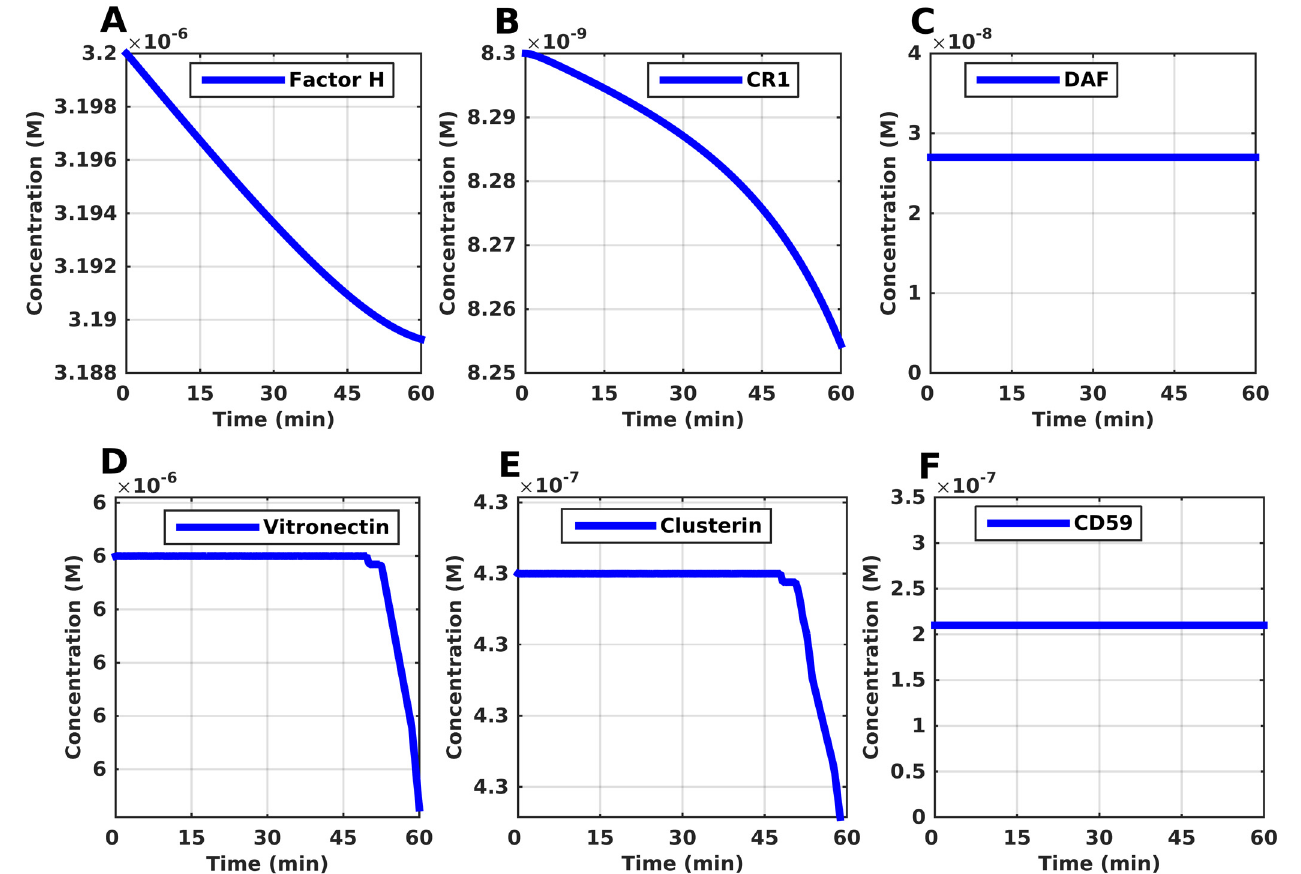
Fig 9. Time profiles for complement regulators Factor H, CR1, DAF, vitronectin, clusterin, and CD59. (A, B) The concentrations of Factor H and CR1 decrease, with Factor H showing initially a linear like response. The initial response of Factor H signifies the regulation taking root at the start of the AP by inhibiting C3(H 2 O) and C3(H 2 O)Bb. (C) The concentration of DAF remains constant and does not change, which highlights the rapid deactivation of any C3b by FH and CR1. (D,E) Vitronectin and clusterin experience a long delay of 52 and 51 minutes respectively before their concentration starts decreasing. Their regulatory component takes root at the formation of fluid C5b-7, which comes at a later stage of complement activation. (F) The response generated for CD59 is the same as that of DAF (no change in concentration). This is expected since DAF remains the same (inhibition of C3 convertase formation), the terminal cascade for MAC pore formation will not take root because formation C5 convertases will also be